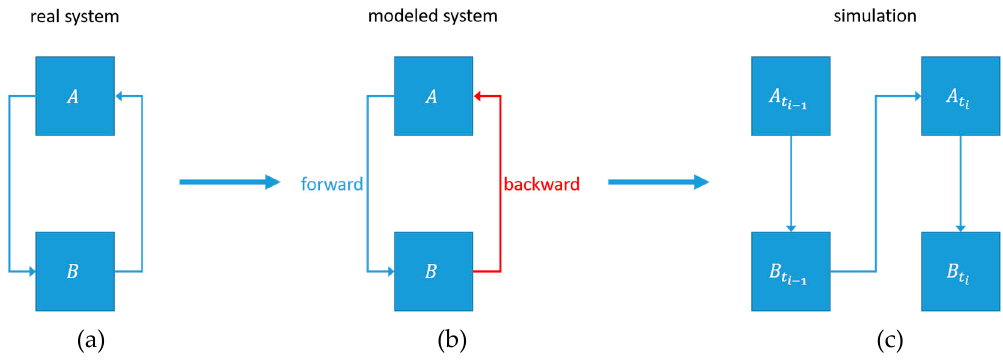
Figure 7. The modelling of a loop. A system containing a loop ( a ), the model of the system ( b ) and an illustration of how the model is simulated ( c ).